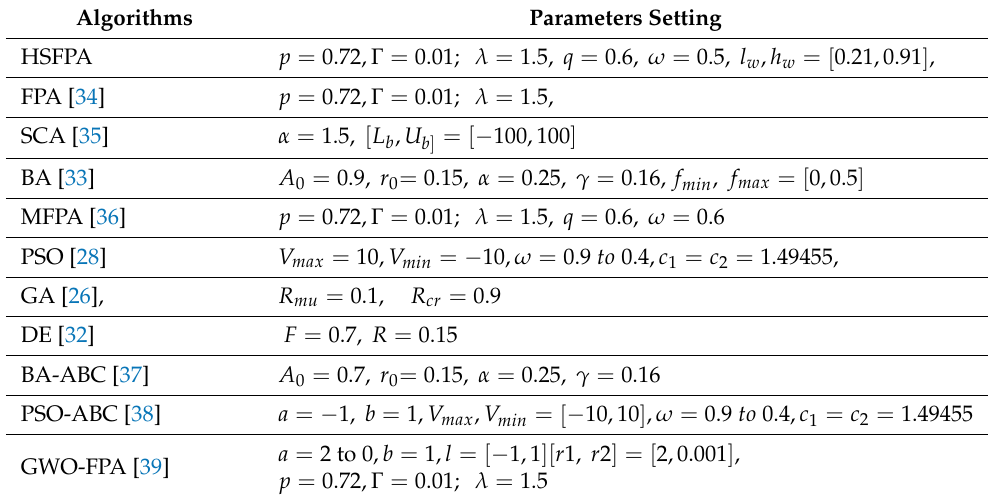
Table 1. Parameters’ settings for the algorithms.